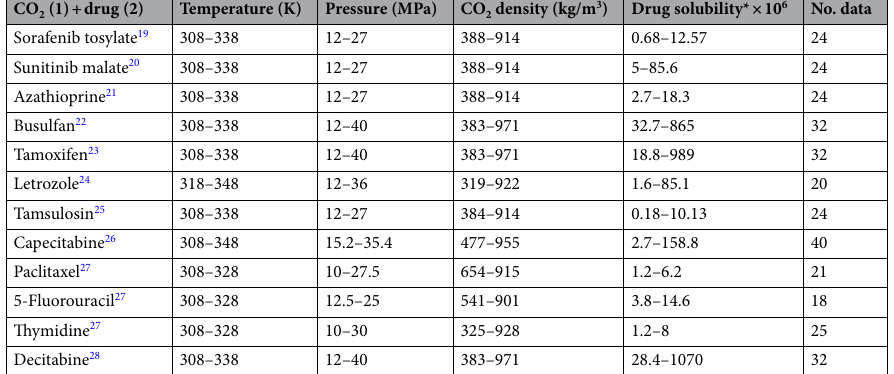
Table 1. Literature data for solubility of anti-cancer drugs in supercritical carbon dioxide.